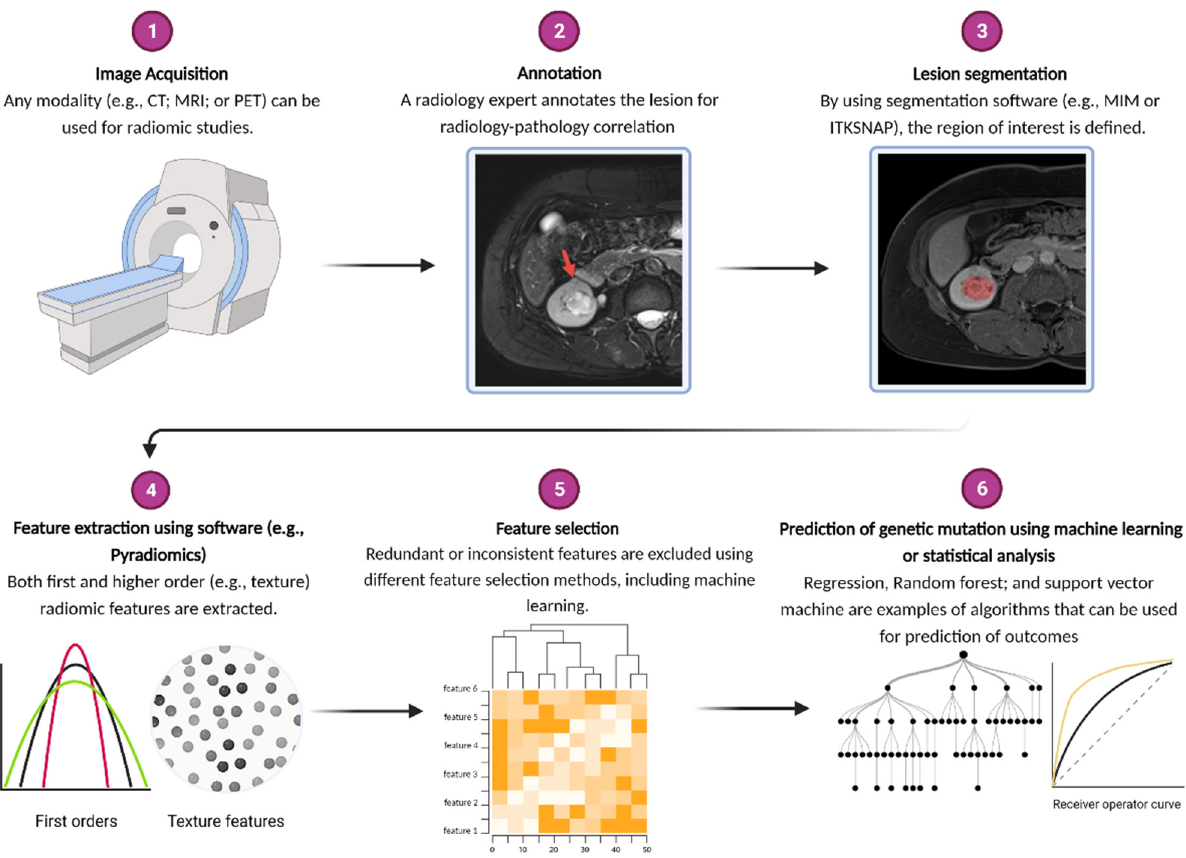
Figure 1. Outline of workflow for radiomic studies. Annotation is particularly important for mul- tifocal masses to ensure matching of radiologically identified lesion with appropriate pathological specimen. Classification of machine learning algorithms is typically binary and thus analyzed using receiver operated curve (ROC), with area under the curve (AUC) used as benchmark for machine performance. Image created using BioRender.com (accessed on 26 November 2021).